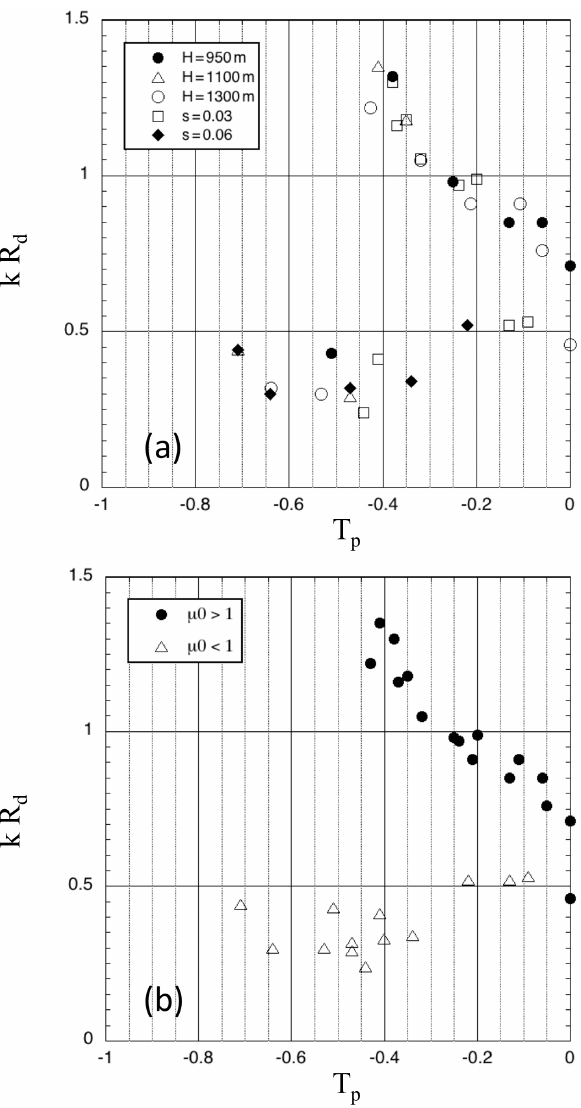
Figure 4. Panel (a) : most unstable wavenumbers k m R d as a function of the topographic parameter T p for a wide range of bottom slopes ( s = 0–6%) and water depths ( H = 600–5000m). Panel (b) : same as panel (a) , but for different values of the mean conversion rate ratio ( µ 0